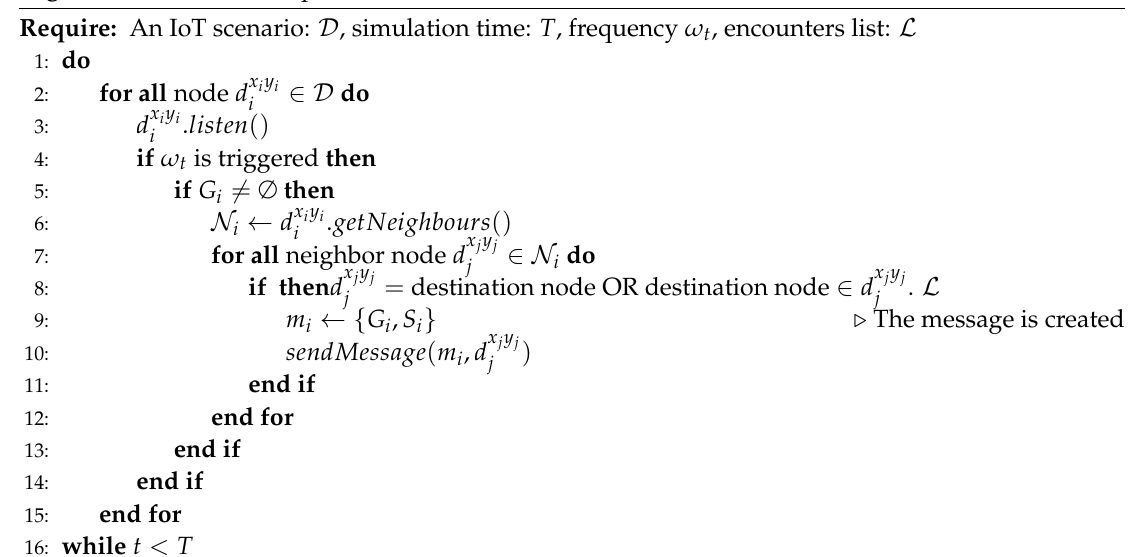
Algorithm 5 SACAR-HC